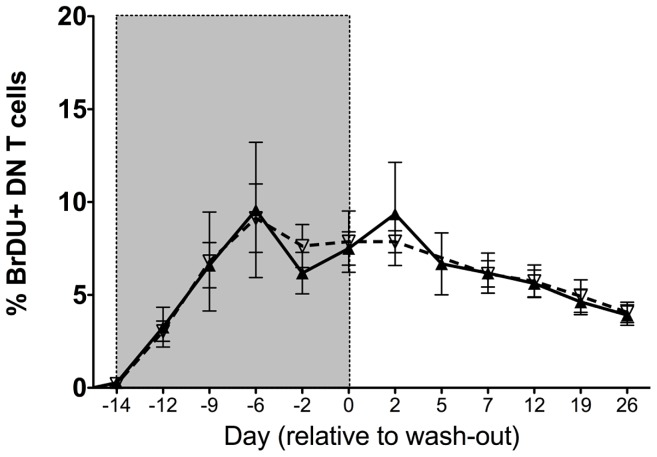
In vivo evaluation of proliferation and turnover of DN T cells in mangabeys.5-Bromo-deoxyUridine (BrDU) labeling was undertaken in 3 uninfected (dotted line, mean) and 5 chronically SIV infected mangabeys (solid line, mean). Analysis of PBMCs indicates that DN T cells incorporate BrDU during the labeling phase (gray shaded area) at a similar rate in the SIV infected and uninfected mangabeys. During the wash-out phase (not shaded) the turnover rate implied by the loss of BrDU from cells was also similar between SIV infected and uninfected mangabeys. Mean ± SEM depicted for each time point.